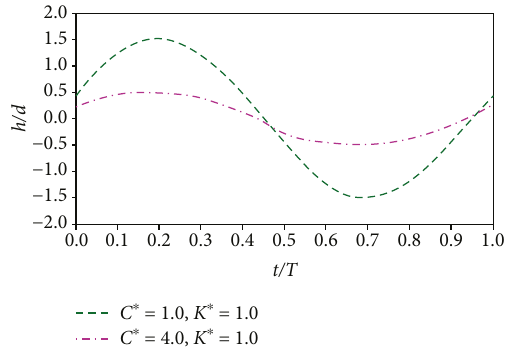
Figure 11: The time variation of h / d of the considered cases with C ∗ = 1 0 and 4.0, K ∗ = 1 0 .